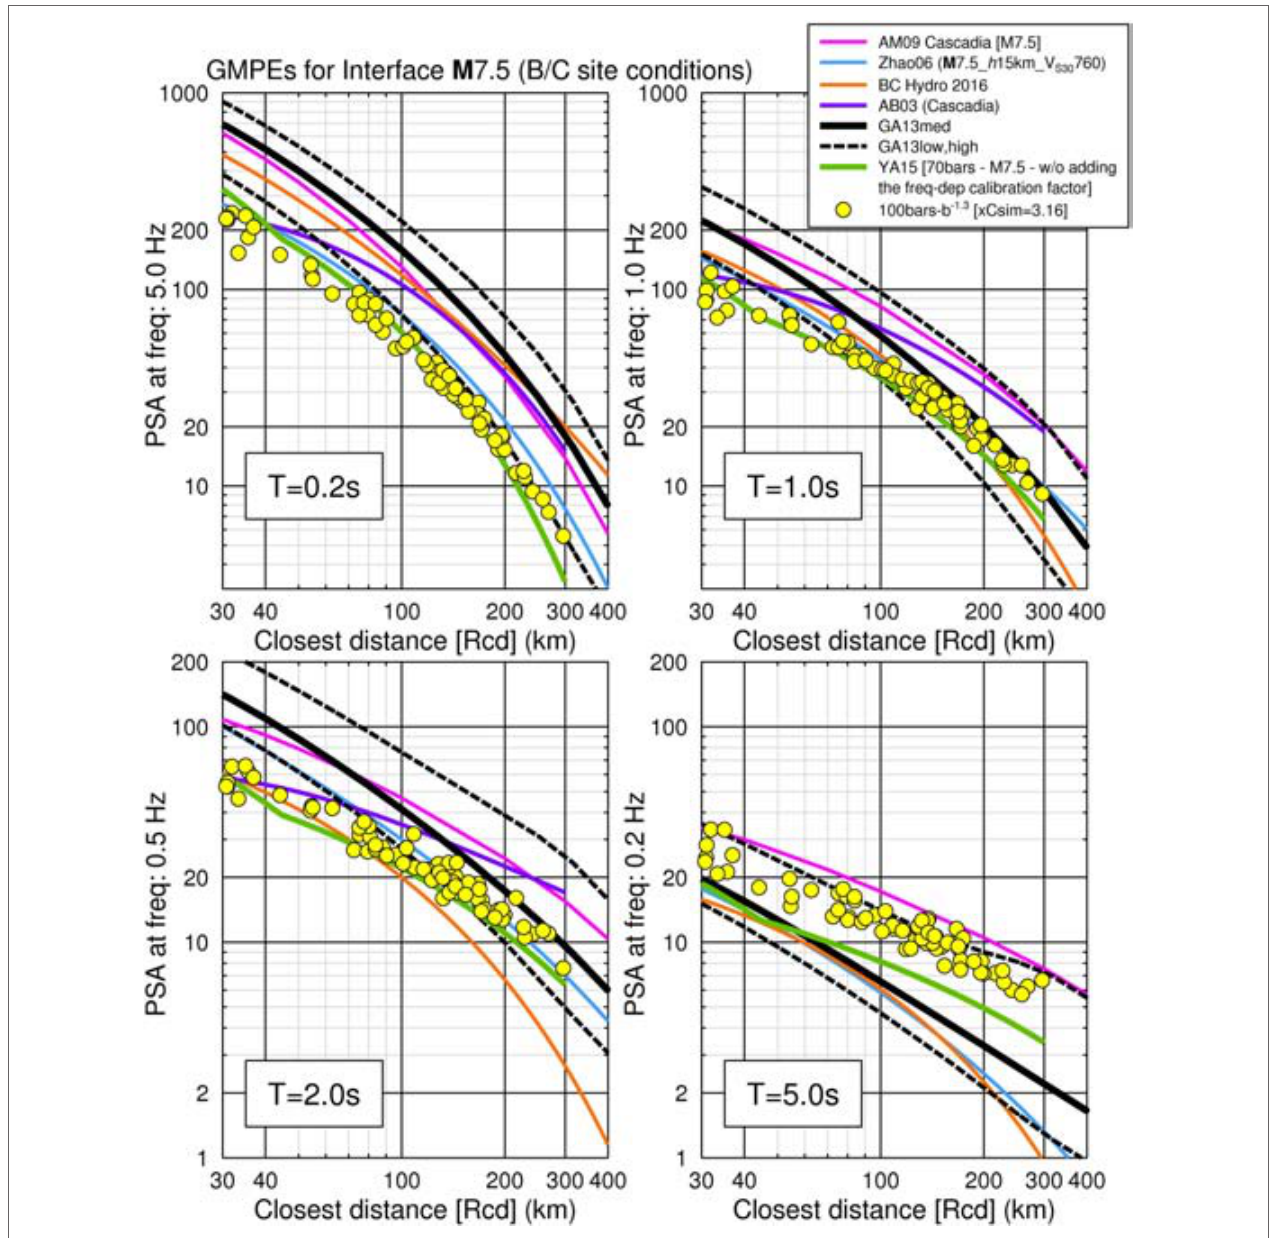
FIGURE 5 | EXSIM-simulated motions for stress parameter of 100bar (yellow circles) and interface ground-motion prediction equations (GMPEs) for an M 7.5 interface event. The interface GMPEs are shown as magenta (AM09), cyan (Zhao06), orange (BC Hydro 2016), purple (AB03), and black (GA13) curves. YA15 point-source model (70bar) is shown as a solid green line. Japan to Cascadia site factor corrections have been applied to both Zhao et al. (2006) and Ghofrani and Atkinson (2013) models to account for the deeper soil profiles in Cascadia compared to Japan, for the same value of V s30 (see Ghofrani et al., 2012 for details). The models reflect forearc attenuation